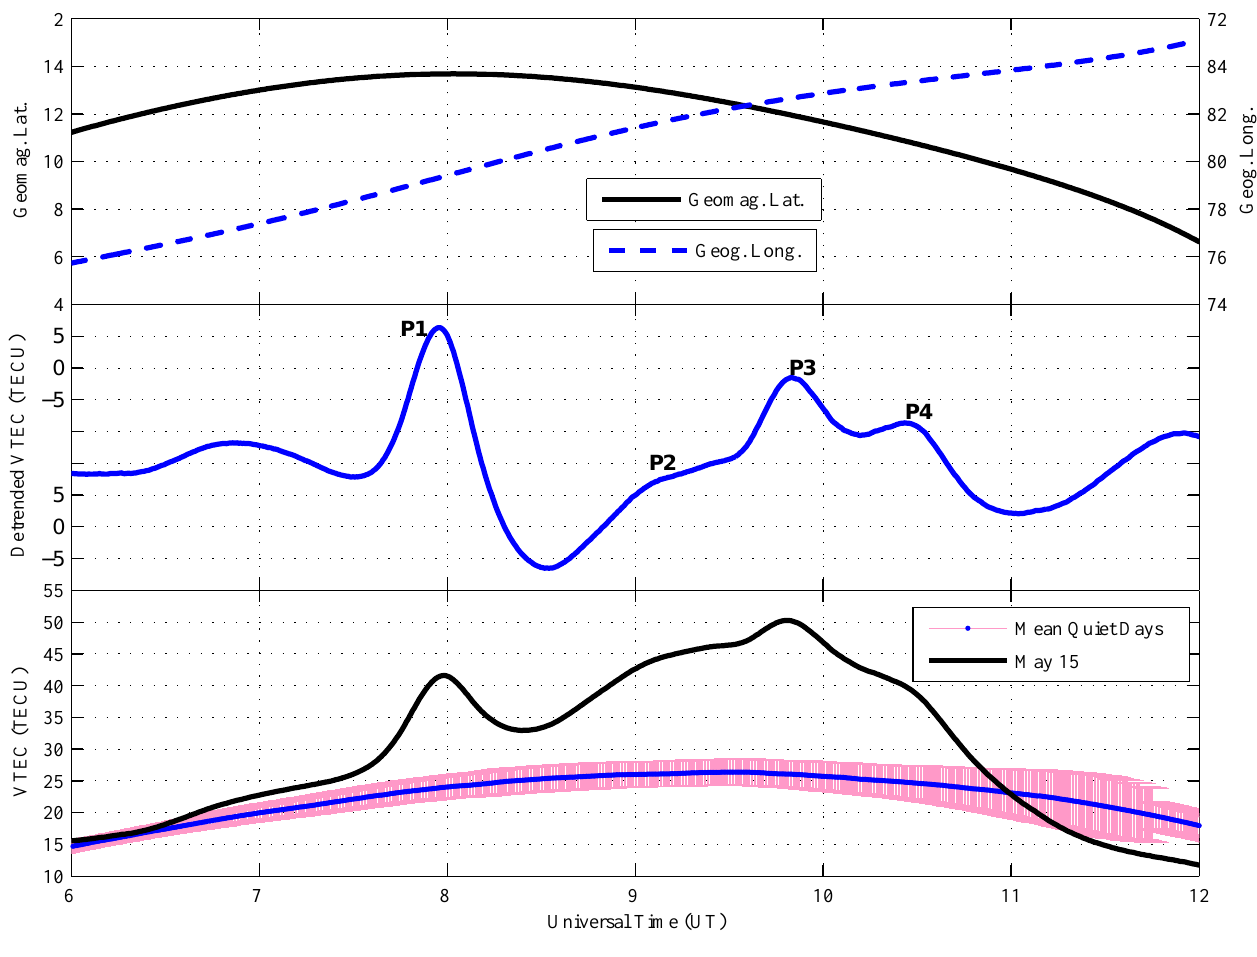
Fig. 4b. VTEC observations from Hyderabad for PRNs 22. Rest is same as Fig. 3a.